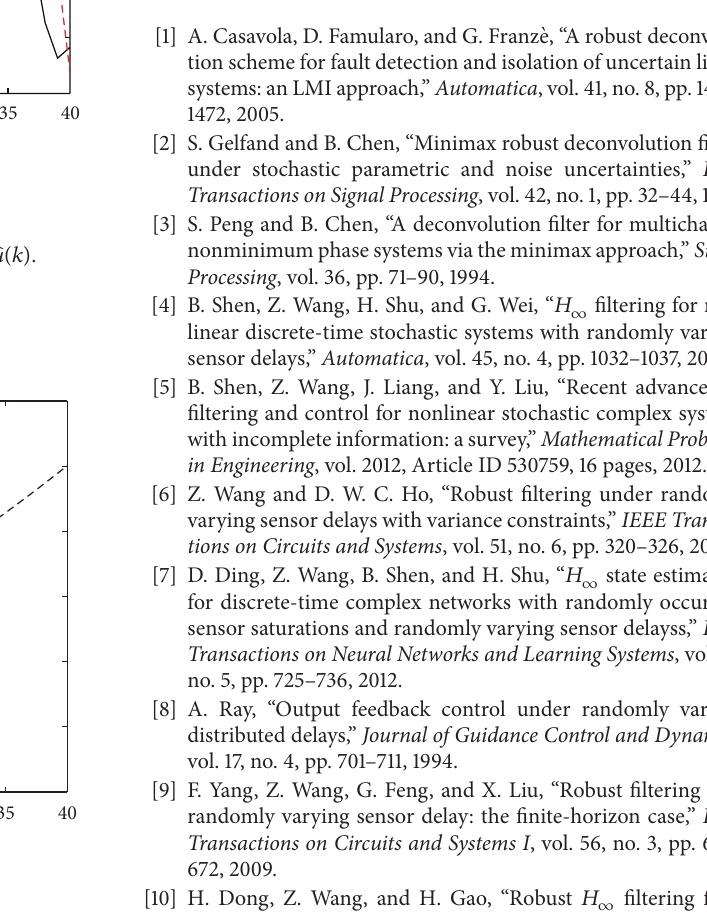
Figure 3: The time-varying probability 𝑝(𝑘)